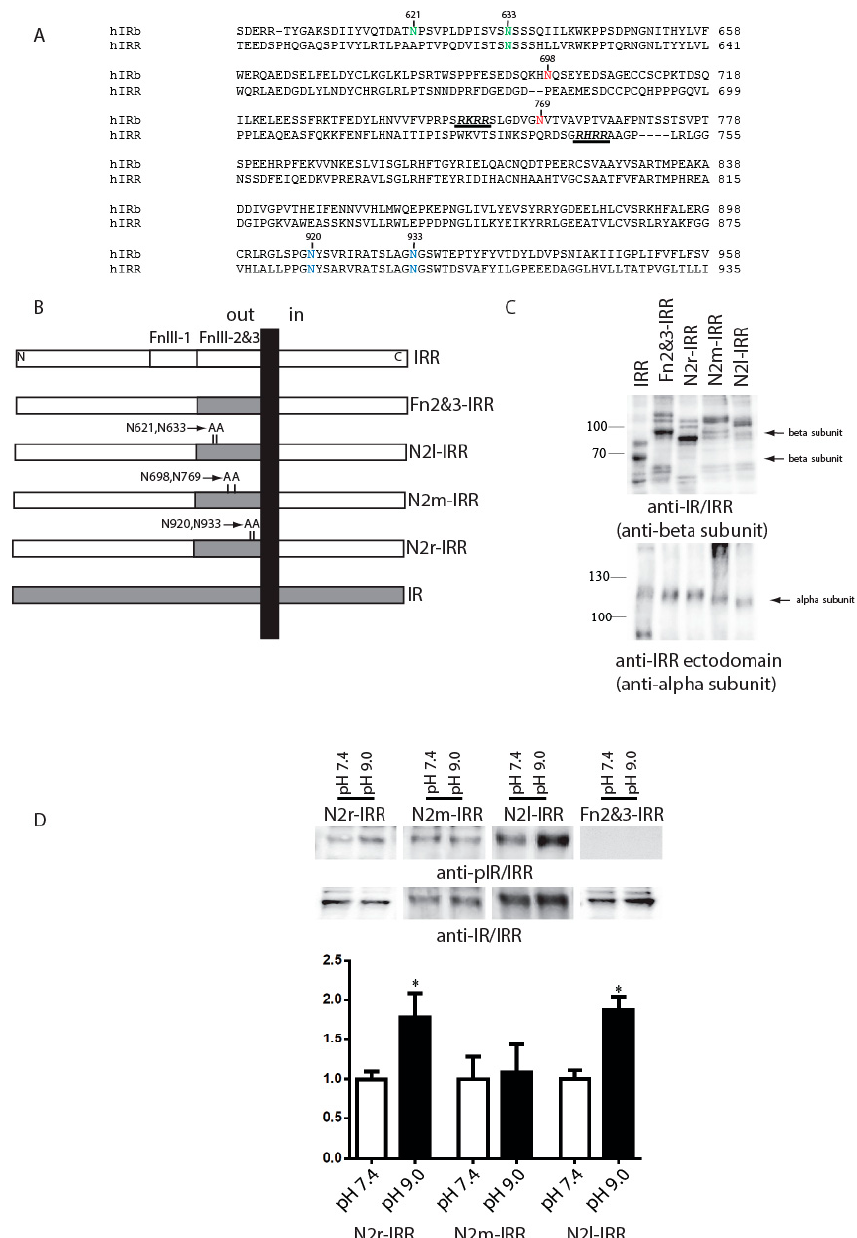
Figure 4. The role of glycosylation within fibronectin repeats domains. ( A ) Alignment of human IR isoform b and human IRR sequences with indication of mutated resides. N2l (left), N2m (middle) and N2r (right) mutations indicated by green, red, or blue colors, correspondently. Sites of proteolysis also indicated by underlying; ( B ) Domain models of the HA-tagged Fn2&3-IRR, N2l-IRR, N2m-IRR, and N2r-IRR alanine mutants or chimeras; ( C ) Western blotting of indicated constructs with anti-IR/IRR antibody (against C-end of IRR) and with anti-IRR ectodomain antibody (against alpha-subunit of IRR); ( D ) Quantitative analysis of the activation of indicated constructs by alkali. For each constructs basal phosphorylation at pH 7.4 indicated as 100%. Transfected cells were incubated with two set of Tris-buffered physiological saline solutions with pH from 7.4 or 9.0. Lysates of transfected cells were directly analyzed by Western blotting with anti-pIR/IRR antibodies and after stripping with anti-IR/IRR antibodies. For the quantitative analysis of Western blots we used Fusion Solo system (Vilber Lourmat, France). Asterisks indicate p < 0.05 in comparison with the basal phosphorylation at pH 7.4 of same constructs. Values are means ± SE ( n ≥ 4).